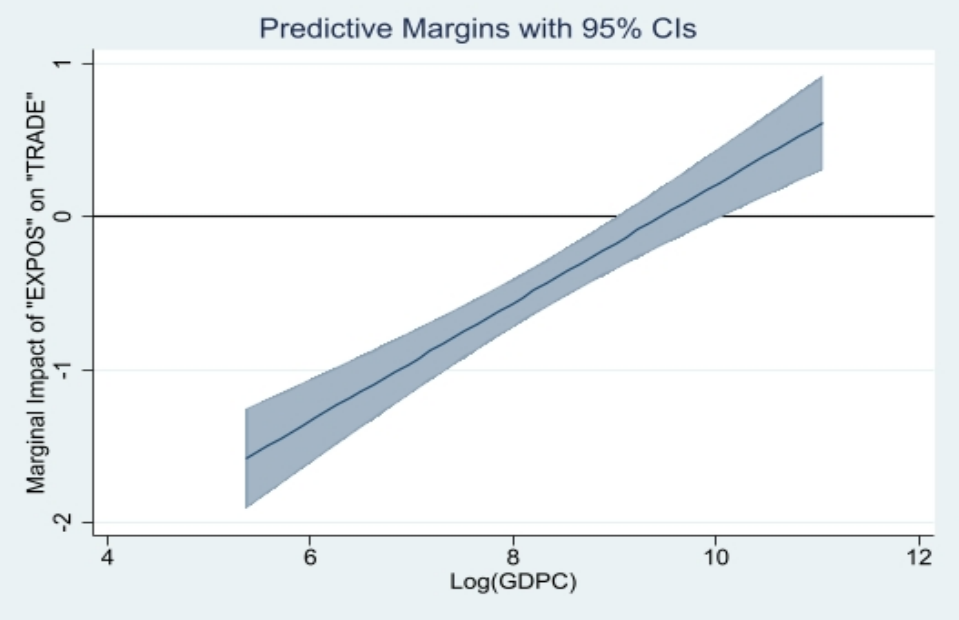
Figure 7. Marginal impact of “EXPOS” on “TRADE” for varying levels of the real per capita income. Source: Author.